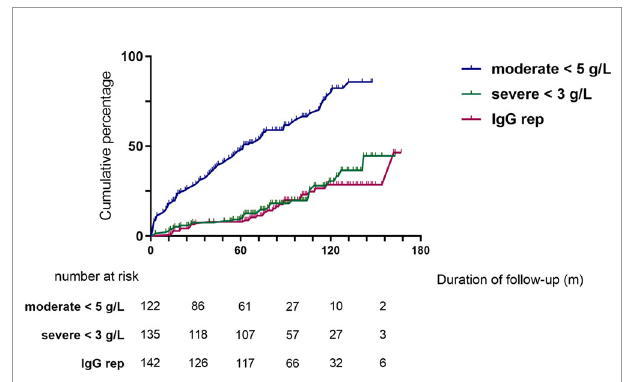
FIGURE 1 | Cumulative incidence of hypogammaglobulinemia and immunoglobulin replacement therapy commencement during